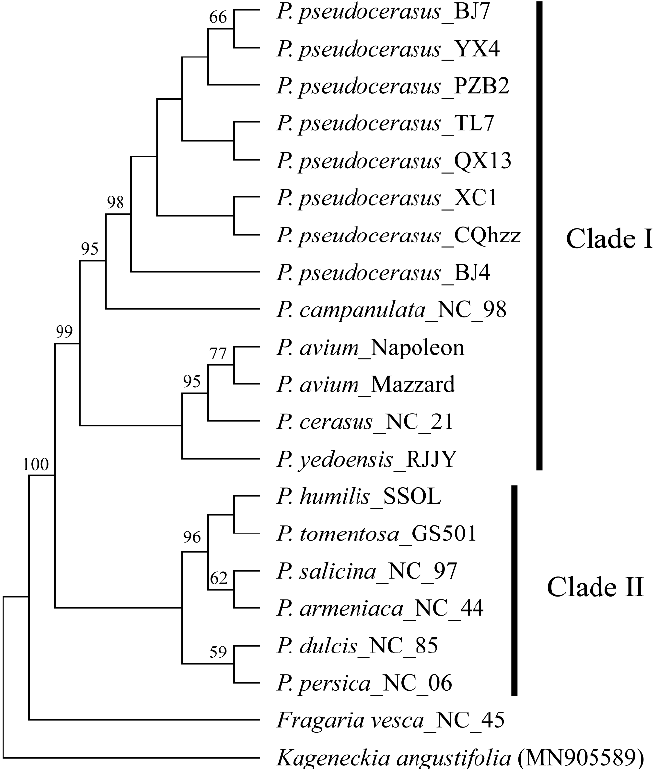
persica , showing that the dwarf cherry is more distantly related to the subgenus Cerasus .